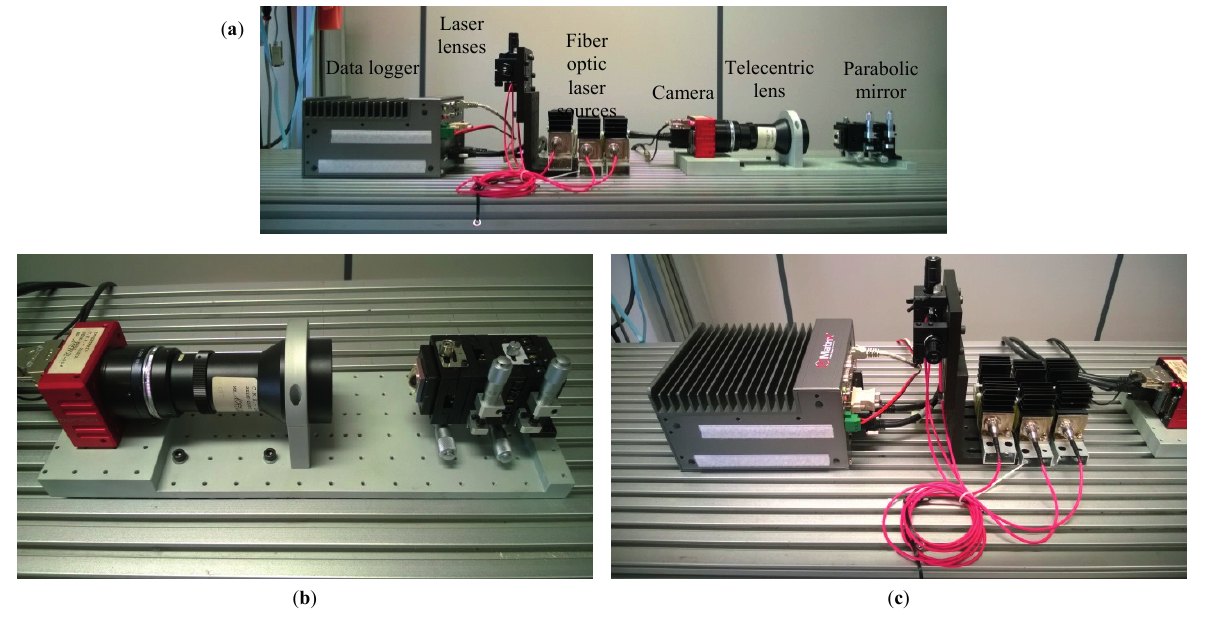
Figure 4. Picture of the actual prototype: ( a ) Overall setup; ( b ) Optical receiver made of the parabolic mirror and the lens-camera set; ( c ) Laser sources and lenses and data logger connected to the